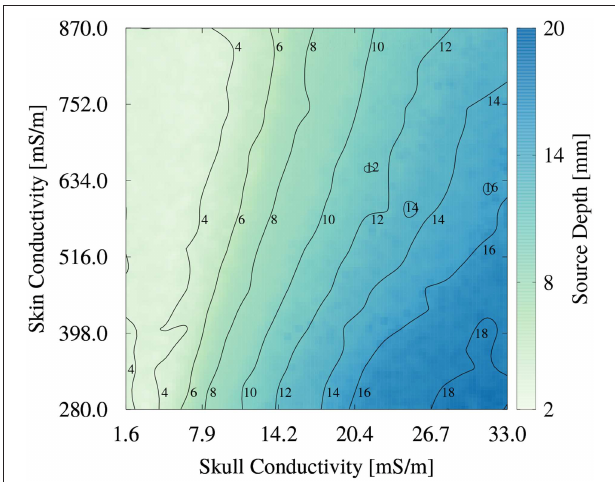
FIGURE 9 | Image plot of source depth as a function of skin and skull conductivities for the multivariate distribution. Contours mark isolines of the source depth.